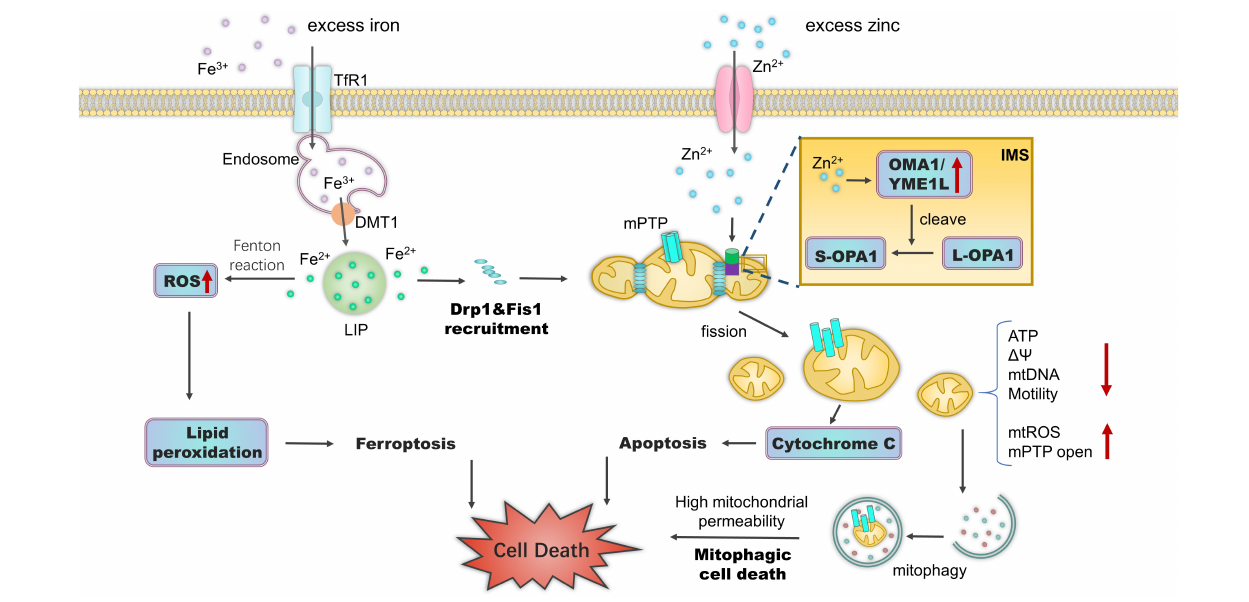
FIGURE 3 | Effects of iron and zinc on mitochondria. Excess intracellular iron accumulation triggers mitochondrial fragmentation by increasing the expression of mitochondrial fission modulators Drp1 and Fis1. Fe 2 + accumulation leads to the Fenton reaction and ferroptosis. Zn 2 + accumulation and import into mitochondria via ion channels trigger mitochondrial depolarization, Drp1-dependent fission, and increased permeability. Under a range of stress stimuli, Zn 2 + in the mitochondrial IMS activates zinc metallopeptidases OMA1 and YME1L to cleave long, fusion-active L-OPA1 to fusion-inactive S-OPA1 isoforms. This results in mitochondrial fragmentation and mitochondrial bioenergetic deficiency. During mPTP opening, fragmented mitochondria trigger mitophagic cell death. Zn 2 + in the cytoplasm can also disrupt iron metabolism. Subsequent ferroptosis can occur via the over-accumulation of lipid ROS. Abbreviations: TfR1, transferrin receptor 1; DMT1, divalent metal transporter-1; LIP, labile iron pool; IMS, intermembrane space; (cid:49)(cid:57) , mitochondrial membrane potential; mtROS, mitochondrial reactive oxygen